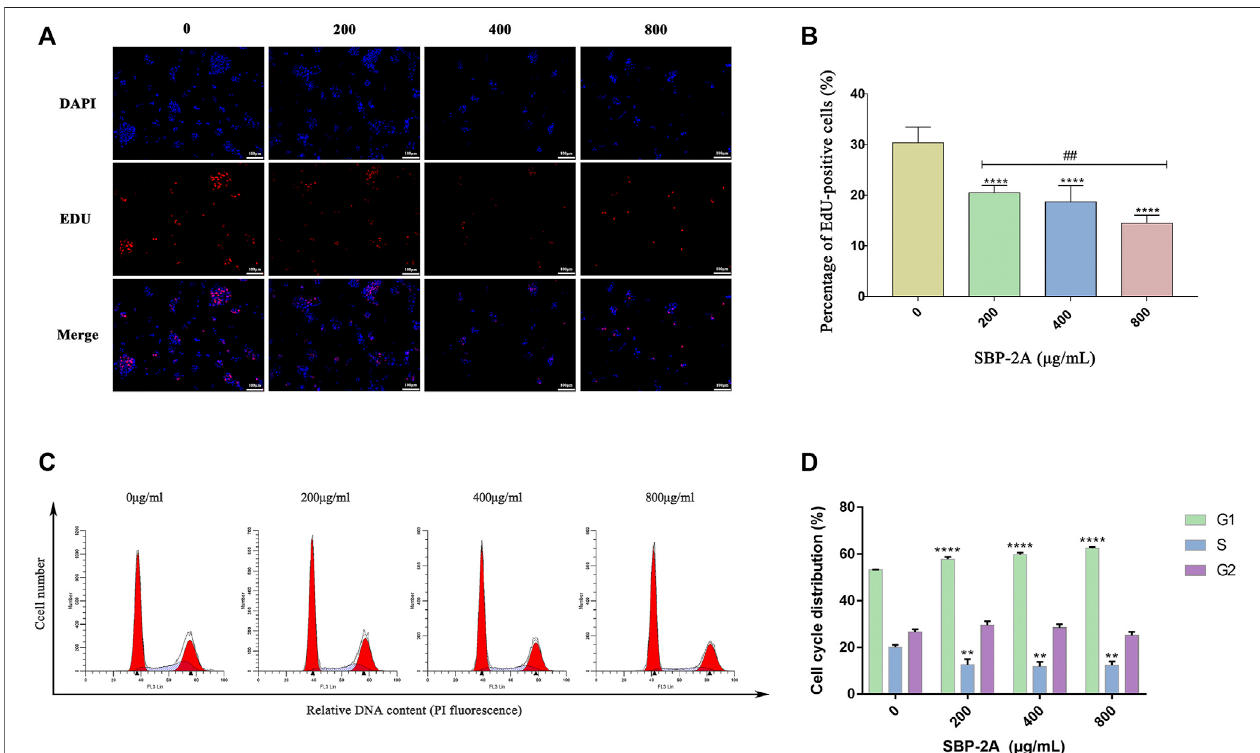
FIGURE 7 | Edu staining (A) , and Edu-positive (+) cells were counted by ImageJ software (B) . Compared to the non-SBP-2A-treated group, **** p < 0.0001. The number of apoptotic cells was determined by Annexin V-FITC/PI double staining (C) , and the DNA contents in the cell cycle was measured quantitatively by fl ow cytometry (D) .